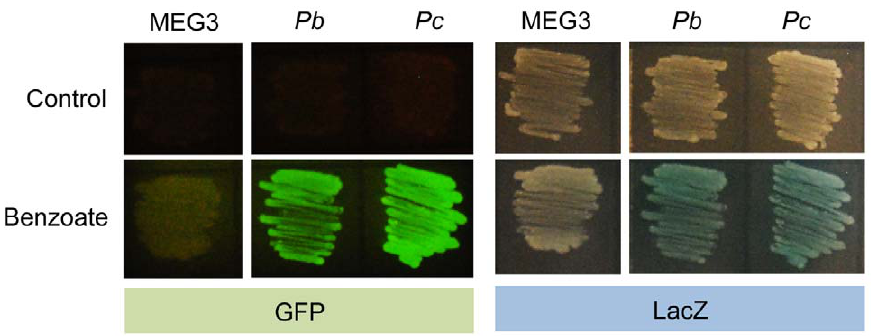
Figure 5. Dual reporter expression in P.putida MEG3 strains. GFP expression is shown on the left, while lacZ expression is shown on the right. The strain with no promoter cloned (labeled as MEG3) was used as a control. The strains having Pb and Pc fused to the dual reporter system presented GFP and LacZ signals when cultured in the presence of 1 mM benzoate.